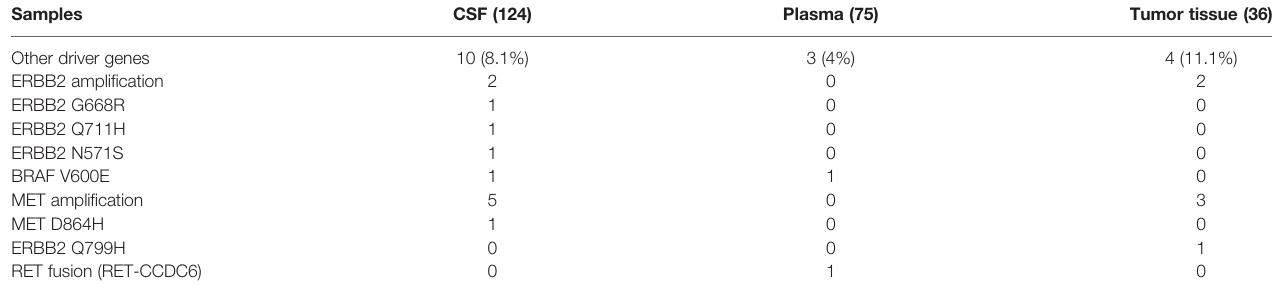
TABLE 4 | Other actionable driver genes in 124 CSF samples.